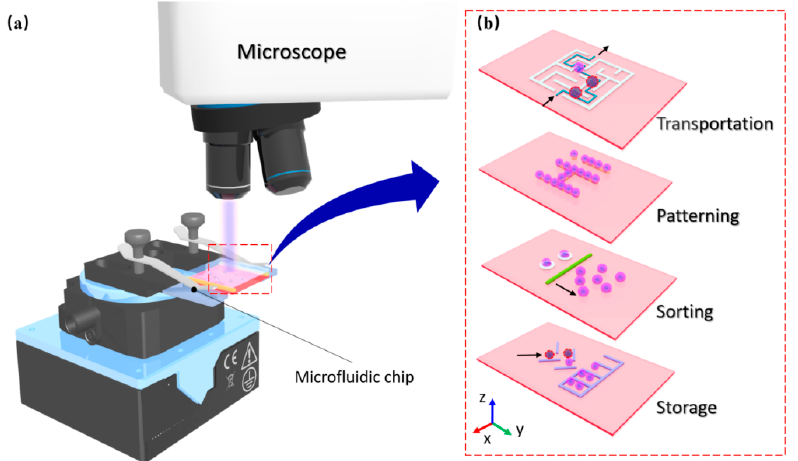
Figure 1. Conceptual overview of manipulation of microparticles via OET. ( a ) Overview of on-chip manipulation system; ( b ) Diverse manipulation of microparticles by light pattern: transportation, patterning, sorting and storage.